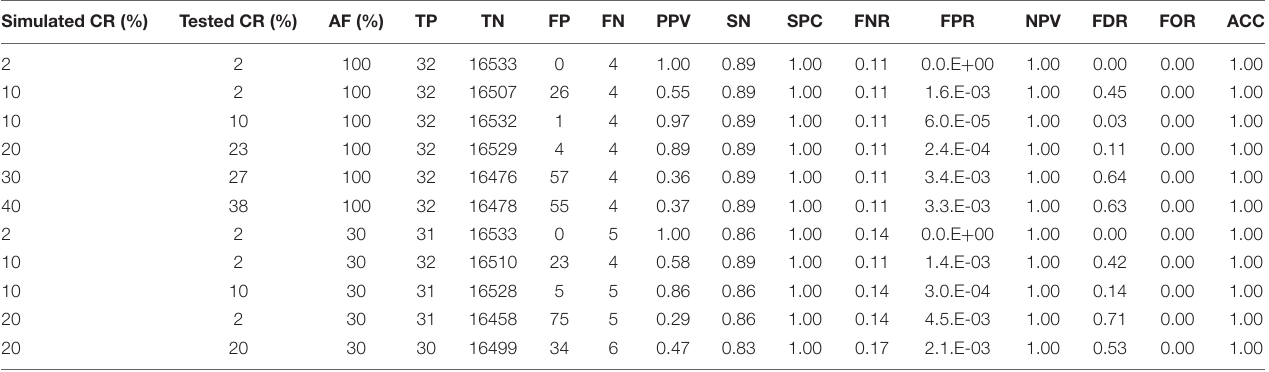
TABLE 4 | Basic statistics for Mutect2 variants in simulated ancient sequences. Simulated CR